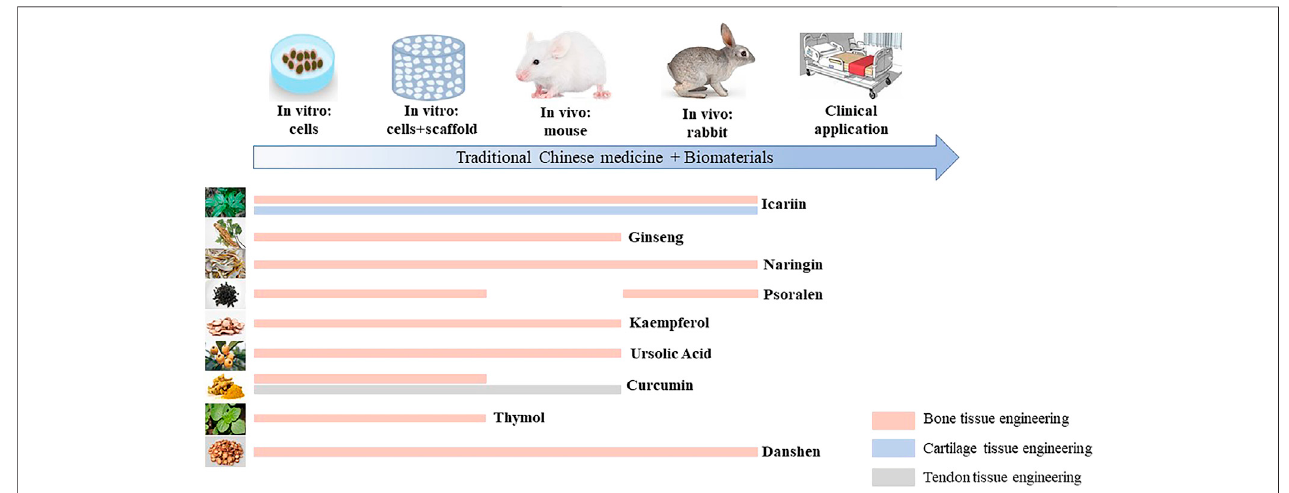
FIGURE 4 | Schematic representation of the musculoskeletal application of traditional Chinese medicines.